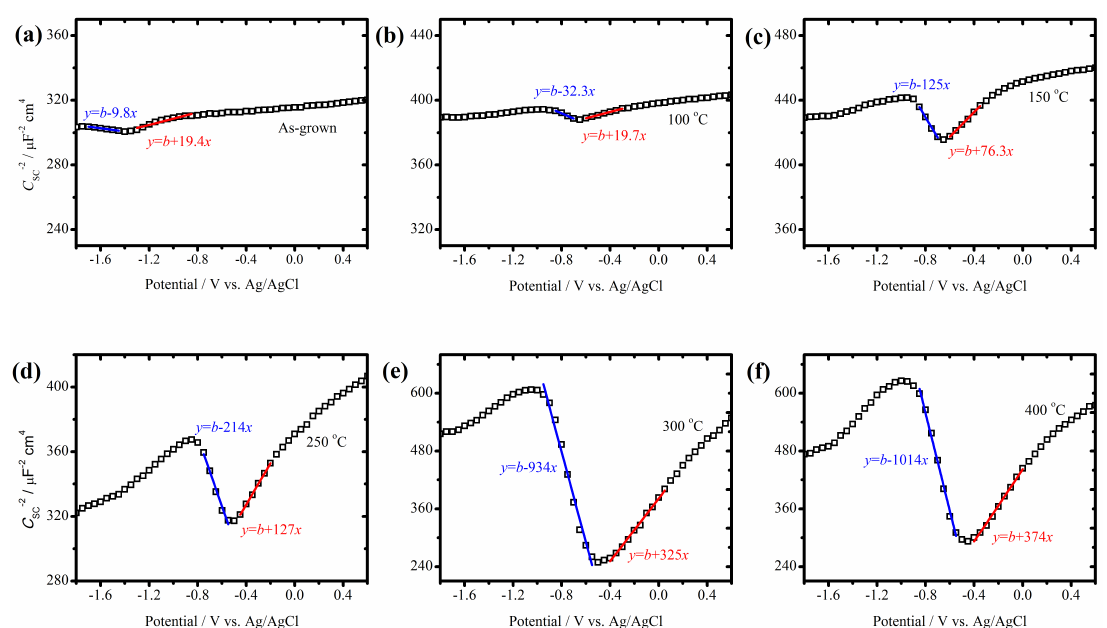
Figure 2. Mott-Schottky plots of annealed AAO layers. The inverse square of space charge capacitance is plotted versus electrode potential between − 1.8 and 0.6 V for the ( a ) as-grown barrier layer, the barrier layers after annealing at ( b ) 100, ( c ) 150, ( d ) 250, ( e ) 300, ( f ) 400 ◦ C for 1 h. The positive and negative slopes of linear segment are